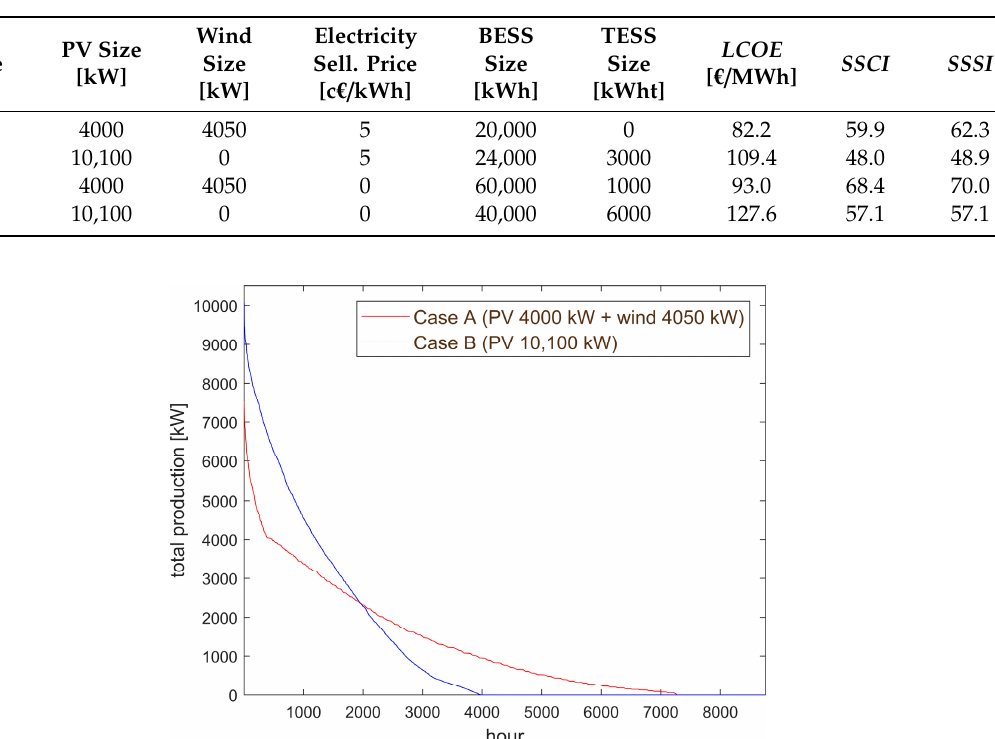
Table 2. Minimum cost solutions.